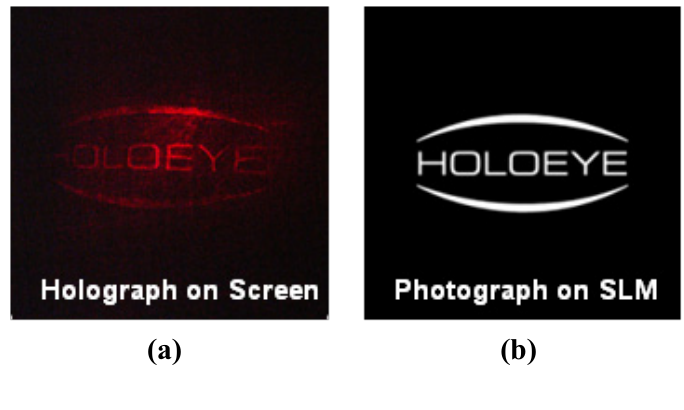
Figure 8. ( a ) Holographic image on screen; and ( b ) original image on